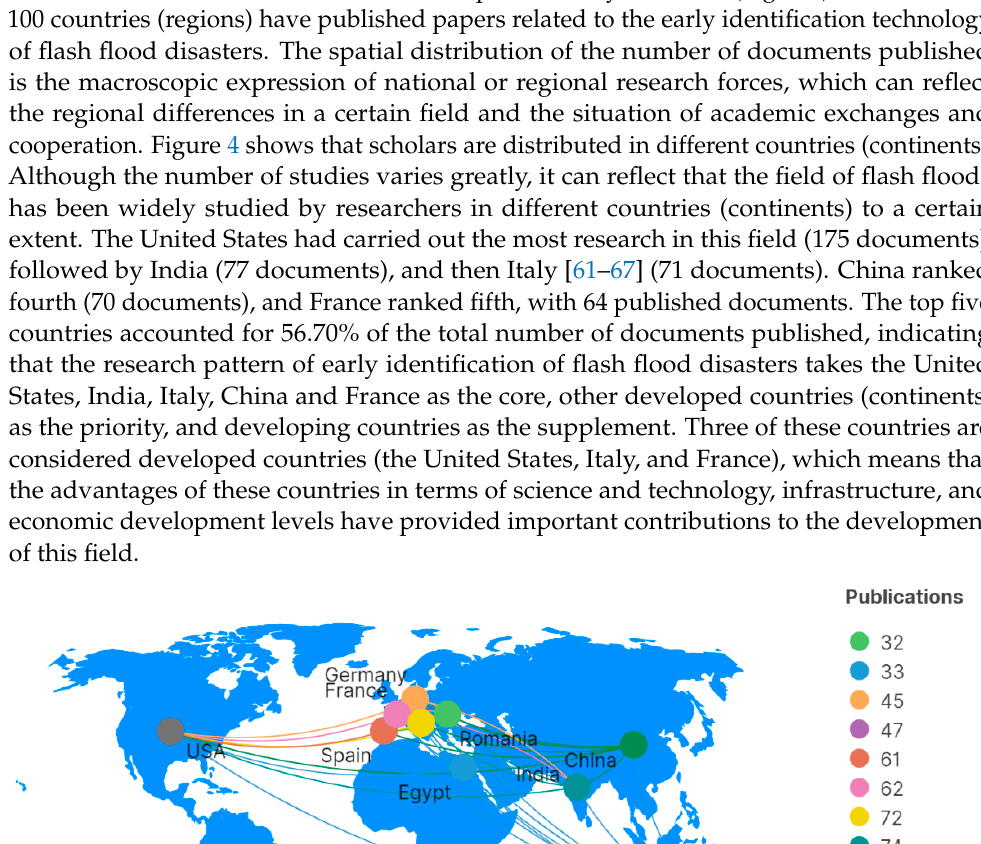
Figure 3. Publication volume over time.